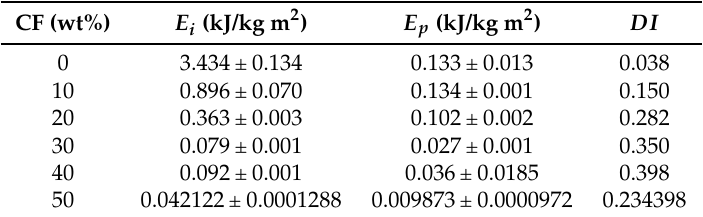
Table 3. Initiation energy E i , propagation energy E p , and ductility index DI for PV set with different filler